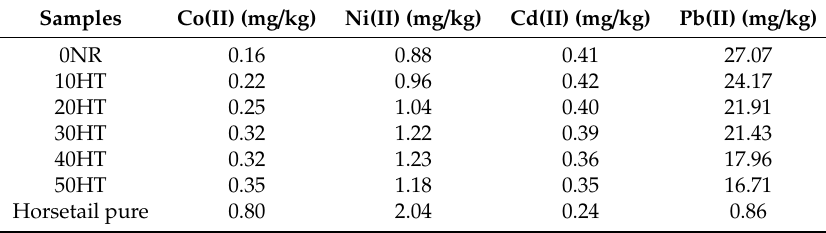
Table 2. Metal(II) concentrations in horsetail and natural rubber